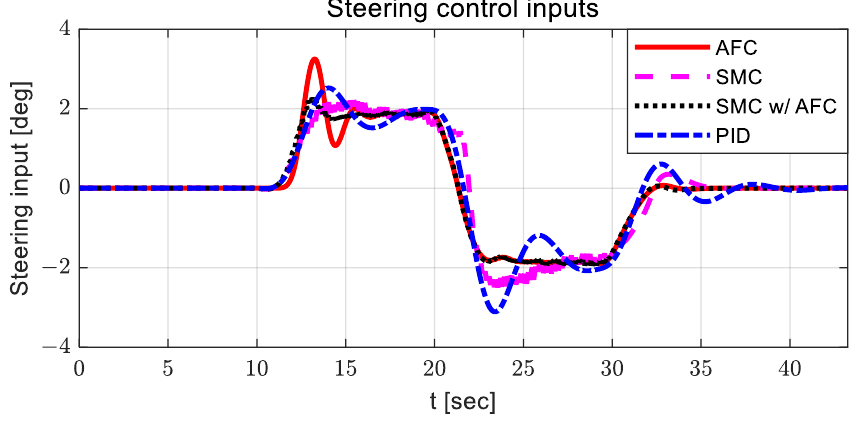
Figure 5. Results: steering control inputs for the curved path tracking.